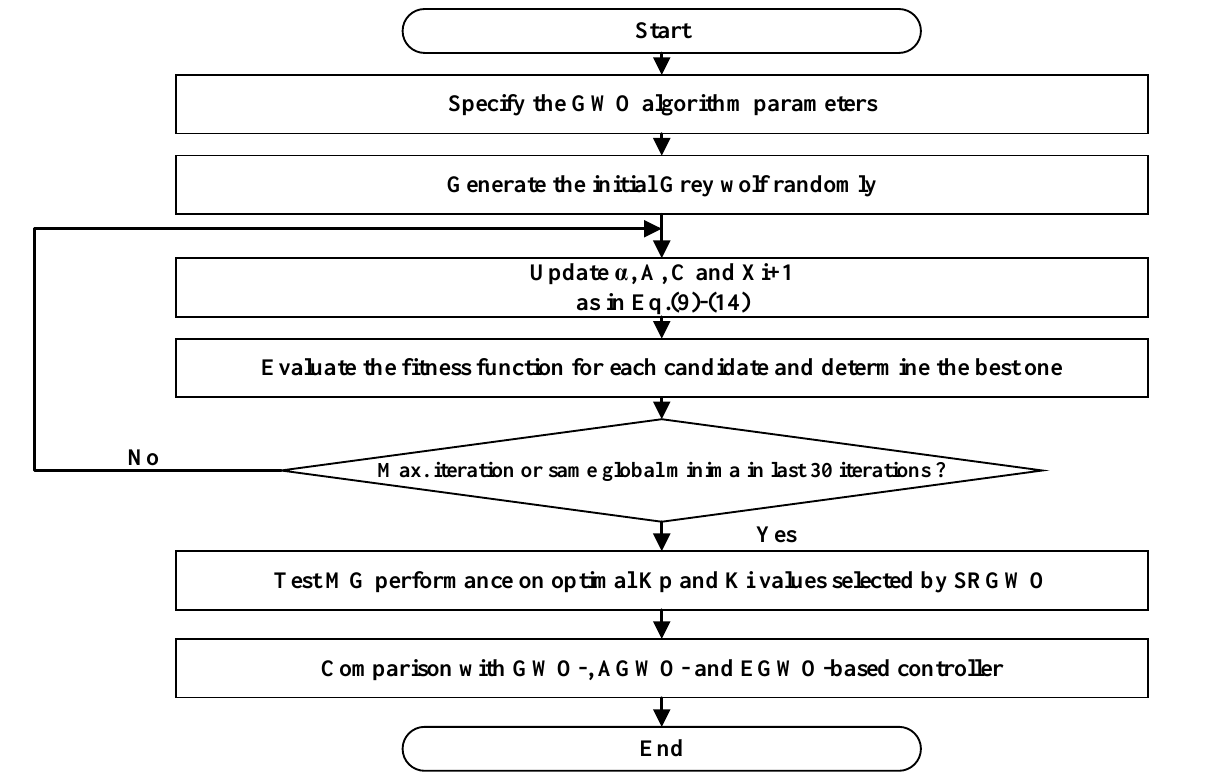
Figure 5. Flowchart of the proposed algorithm.